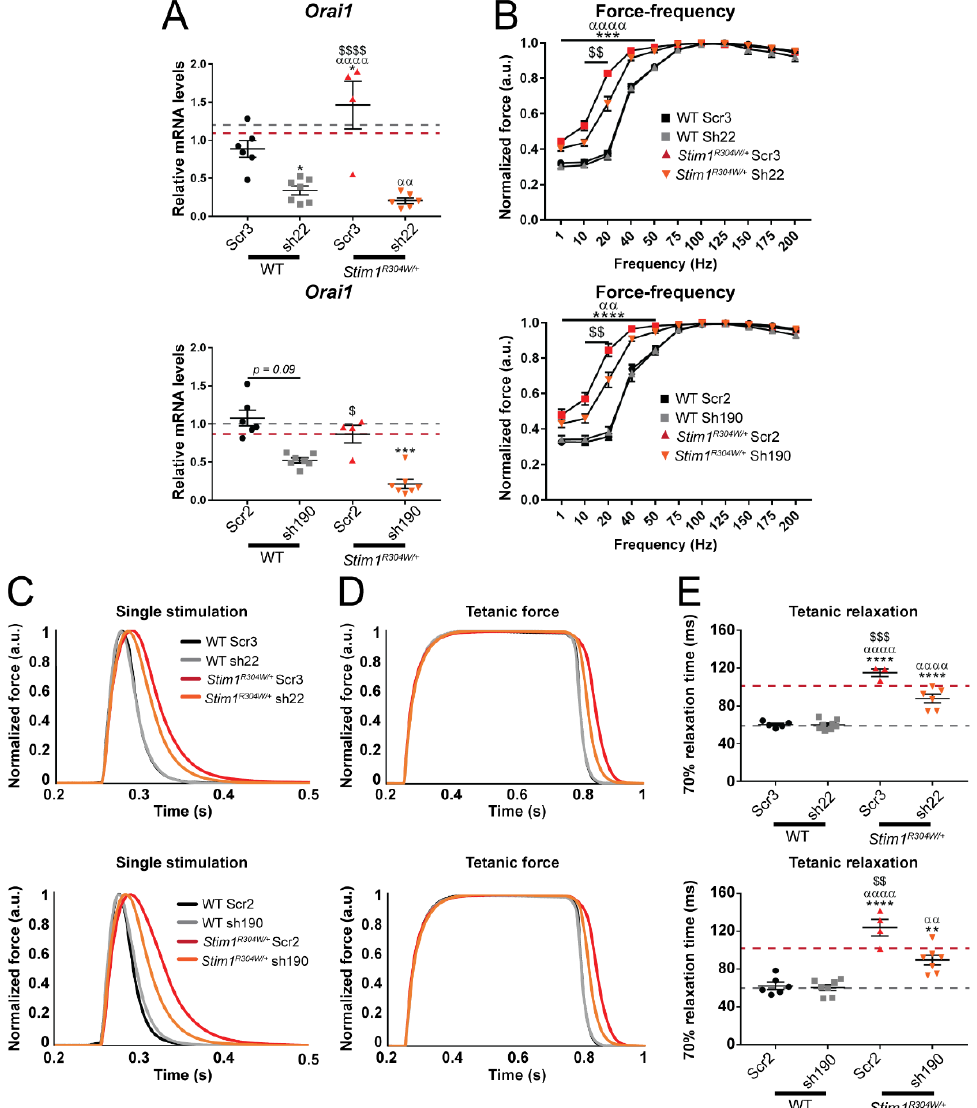
Figure 4. Improved muscle contraction and relaxation properties in TAM/STRMK mice